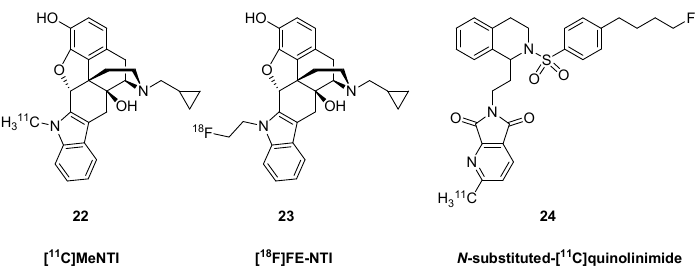
Figure 4. Labeled δ-opioid receptor ligands. Figure 4. Labeled δ -opioid receptor